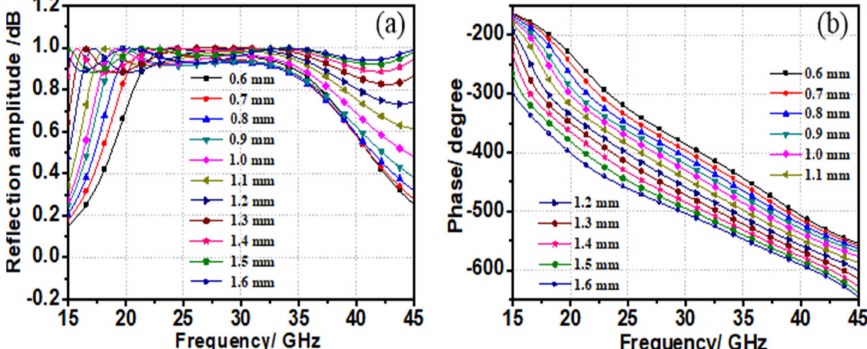
Figure 4. Lengths of a increases from 0.6 mm to 1.6 mm, and rotation angle β = 45 ◦ , ( a ) the reflection amplitude and ( b ) phase of cross-polarized reflection coe ffi cients of x -polarized waves incident vertically when a takes di ff erent lengths.